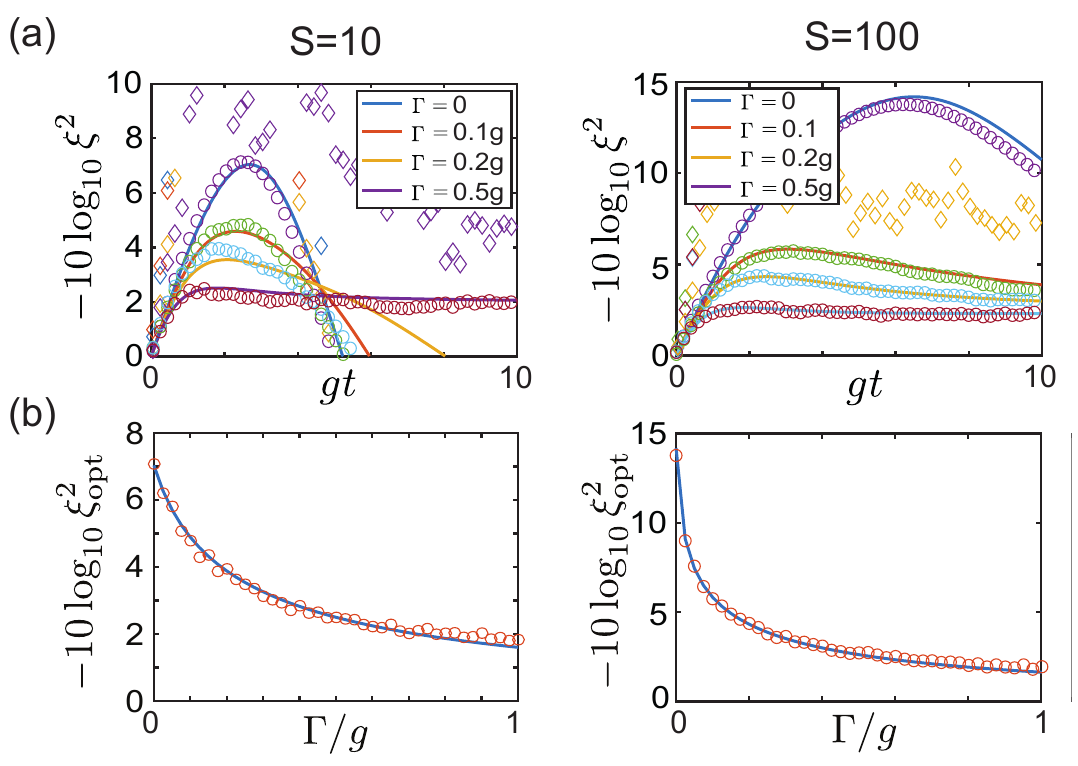
Figure 5: (a) Time evolution of the squeezing parameter ξ for different decay rates Γ / g = 0,0.125,0.25,0.5 and for S = 10 and S = 100. (b) Maximum of the squeezing parameter ξ as a function of the decay rate Γ . In all plots the solid lines represent opt the exact results, while the diamonds and circles have been obtained from a stochastic sampling of the Q - and Wigner distribution. The system is initialized in the state with all spins pointing down, | S z = − S 〉